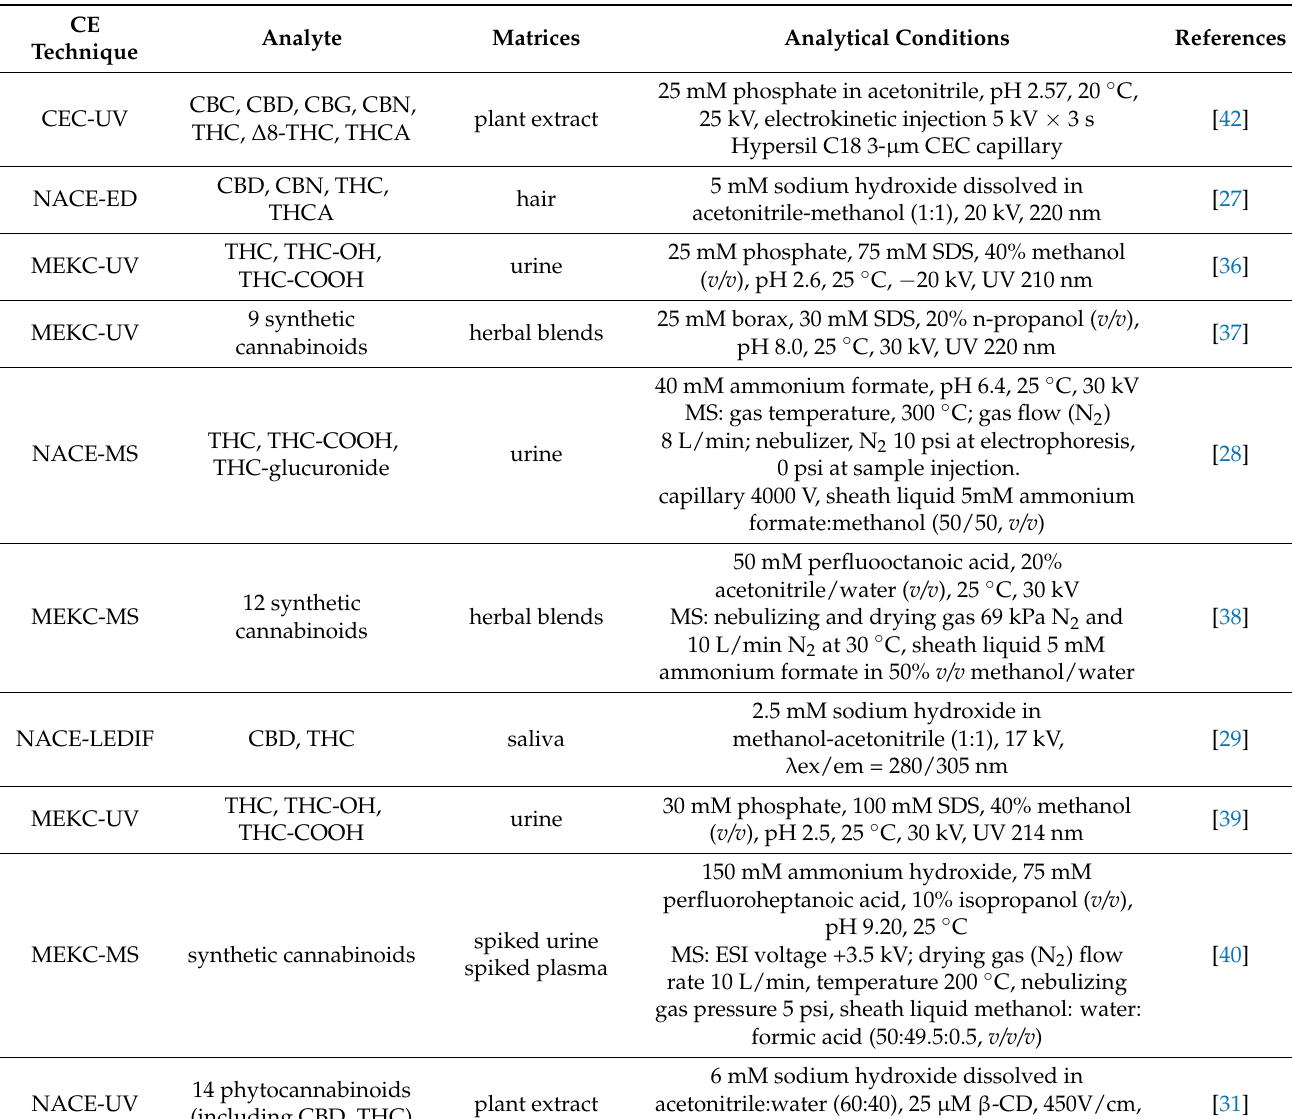
Table 1. CE methods for the determination of